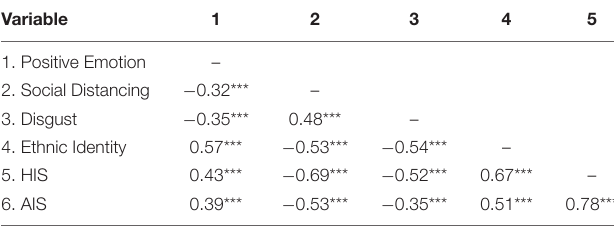
TABLE 2 | Study 2: Bivariate Pearson Correlations.